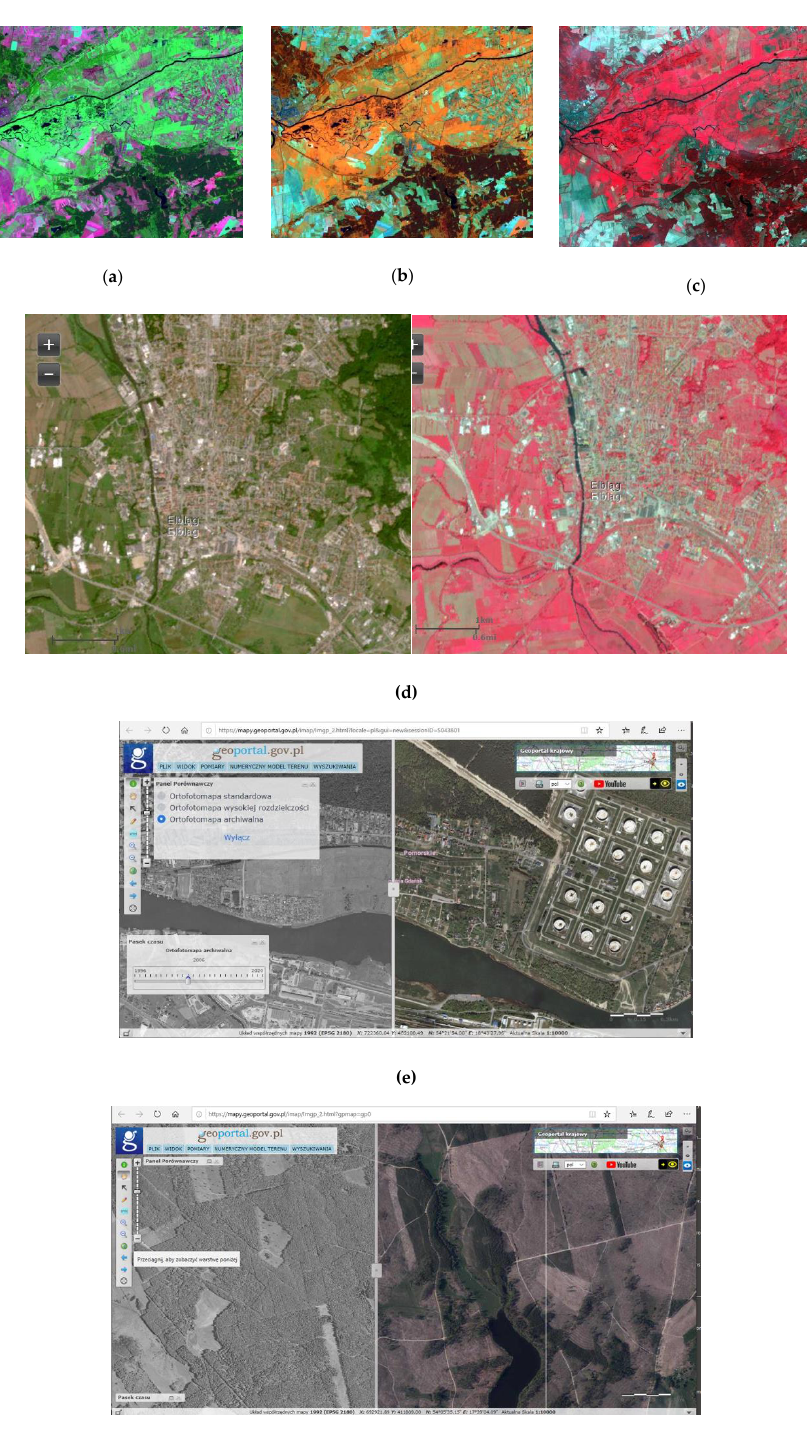
Figure A1. CORINE Land Cover types in Polish Baltic coastal zone in ( a ) 1990; ( b ) 2018; ( c ) CLC classes – level 2; ( d ) CLC changes in 1990–2018.